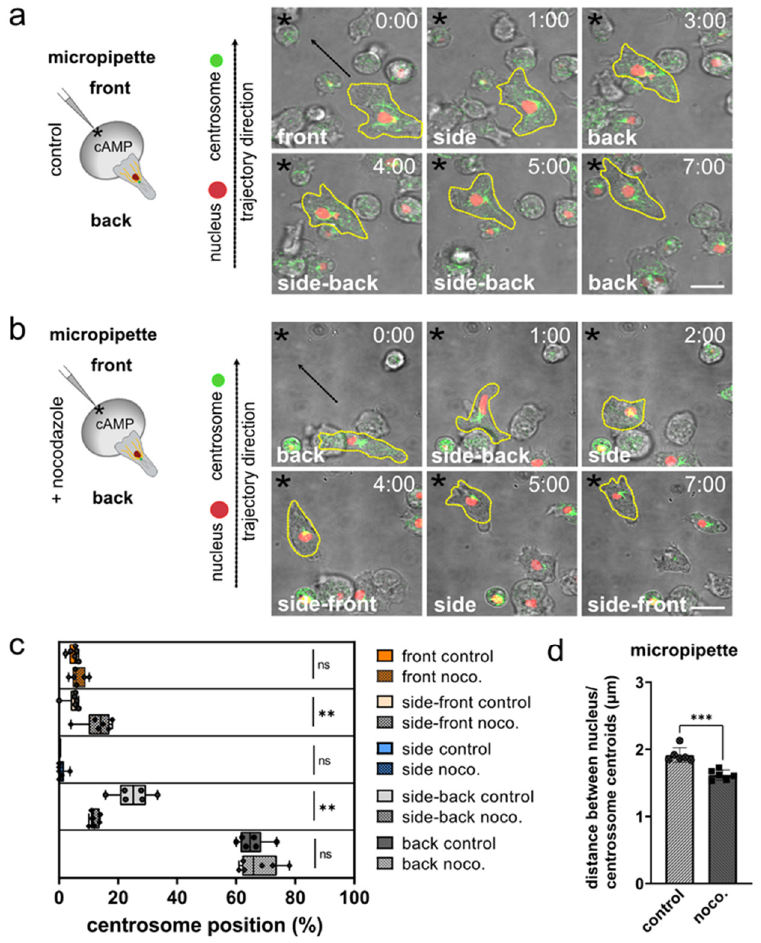
Figure 2. In aggregation-competent Dictyostelium cells moving in a gradient of cAMP released from a micropipette, the centrosome is positioned behind the nucleus, but frequently relocates when microtubules are disrupted. ( a , b ) Schemes (left) and representative microscopy images (right) of Dictyostelium cells migrating toward a micropipette tip releasing cAMP (indicated by asterisks). The cells express both the nuclear marker mRFP-histone (red), and GFP-tubulin (green) to highlight centrosomes and microtubules. Time is indicated in min and s at the top. The cell shape is highlighted by a yellow dashed line. Images were taken with 10 s-frame intervals. N = 6, number of cells = 50 for control; N = 6, number of cells = 52 for nocodazole. ( a ) Shows control cells, ( b ) nocodazole-treated cells. ( c ) Analysis of centrosome positions in control and nocodazole-treated (noco.) cells. Note that there were no events for the side control. ( d ) Nocodazole treatment decreases the distance between the center position (centroid) of the nucleus and the center of the centrosome. Scale bars are 10 µ m. * p < 0.05, ** p < 0.01, *** p < 0.001 are significant, and ns = not